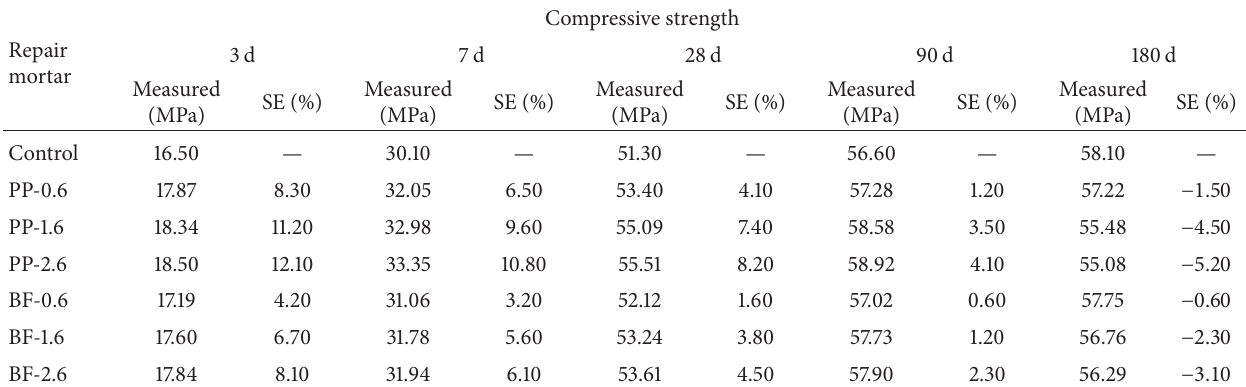
Table 6: Compressive strength test results of the